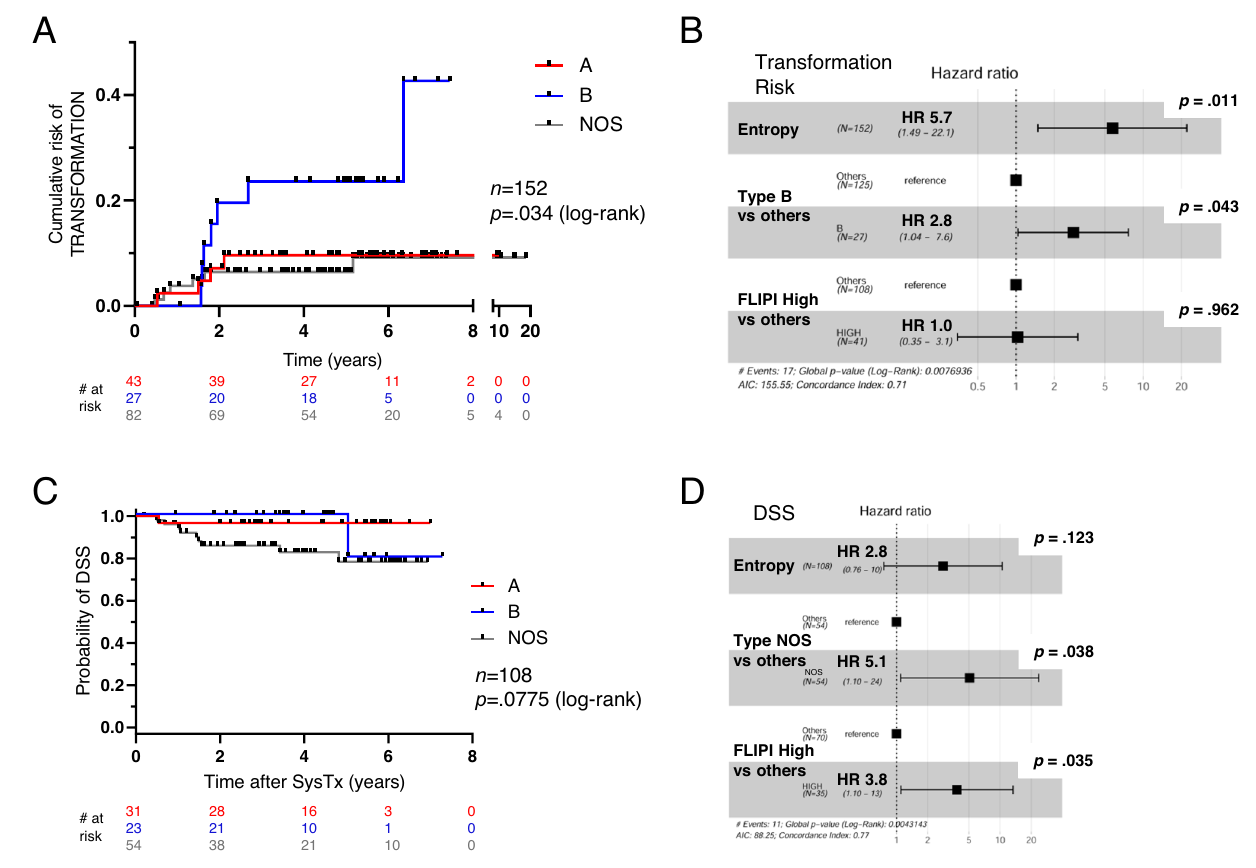
Fig. 7| FLsubtypesshowdistinct clinicaloutcomes.A , C Kaplan – Meierplotsfor A risk of transformation and C disease-speci fi c survival (DSS). B , D Forest plots from multivariate analyses for B transformation risk and D DSS using Cox